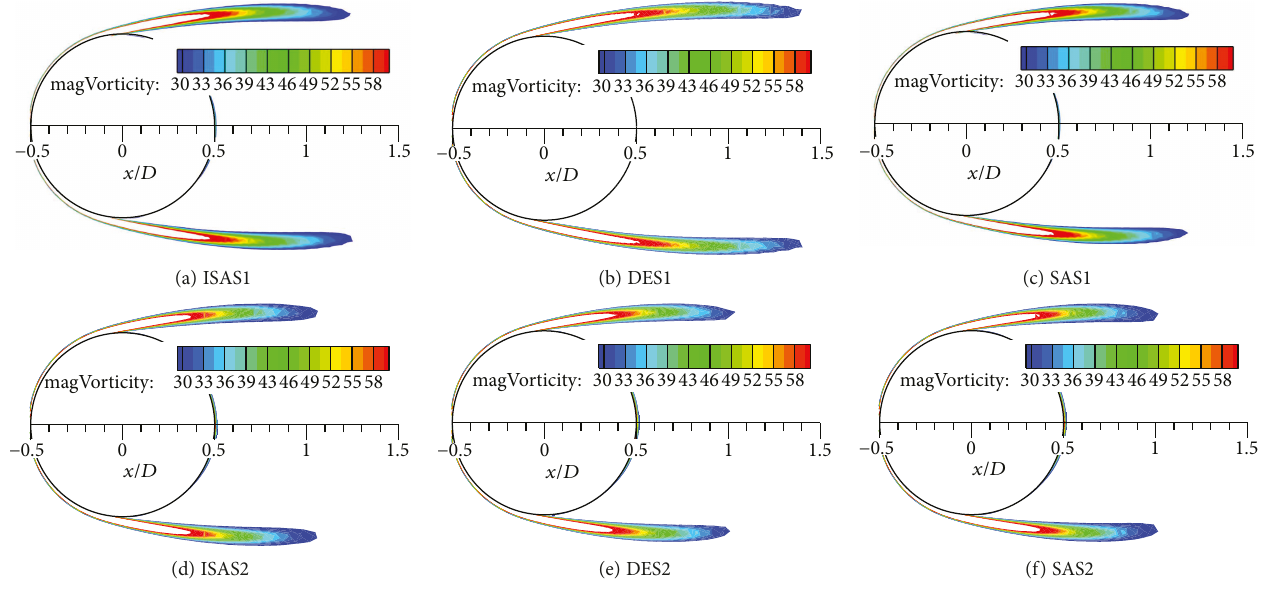
Figure 5: Separating shear layers displayed by the mean vorticity